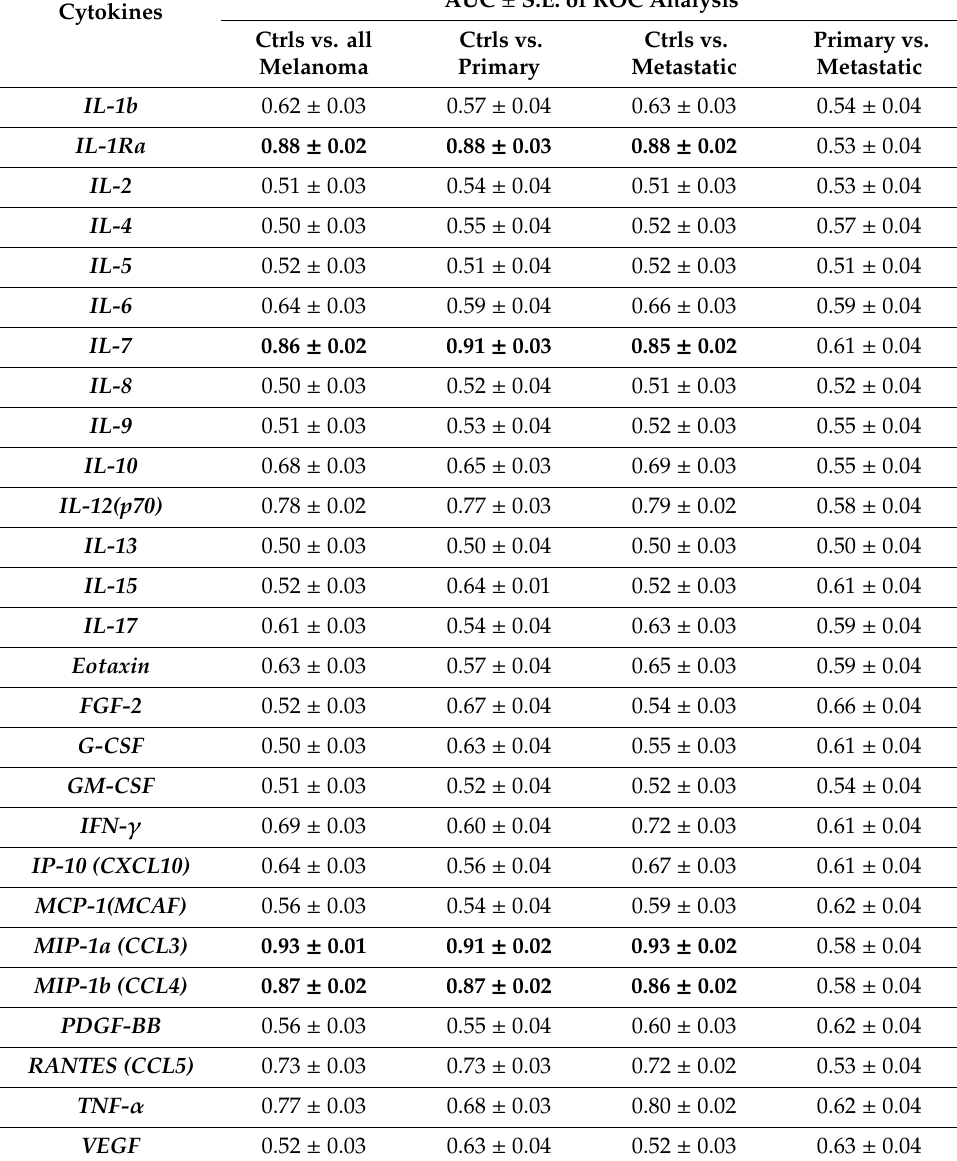
Table 9. ROC analysis of the tissue expression data. For each molecule, the AUC values for the ROC analysis was calculated for the following sets of expression values: controls vs. all melanoma, controls vs. primary melanoma, controls vs. metastatic melanoma, and primary melanoma vs. metastatic melanoma samples. For every AUC value, the standard error of the measure obtained by the cross-validation procedure is also